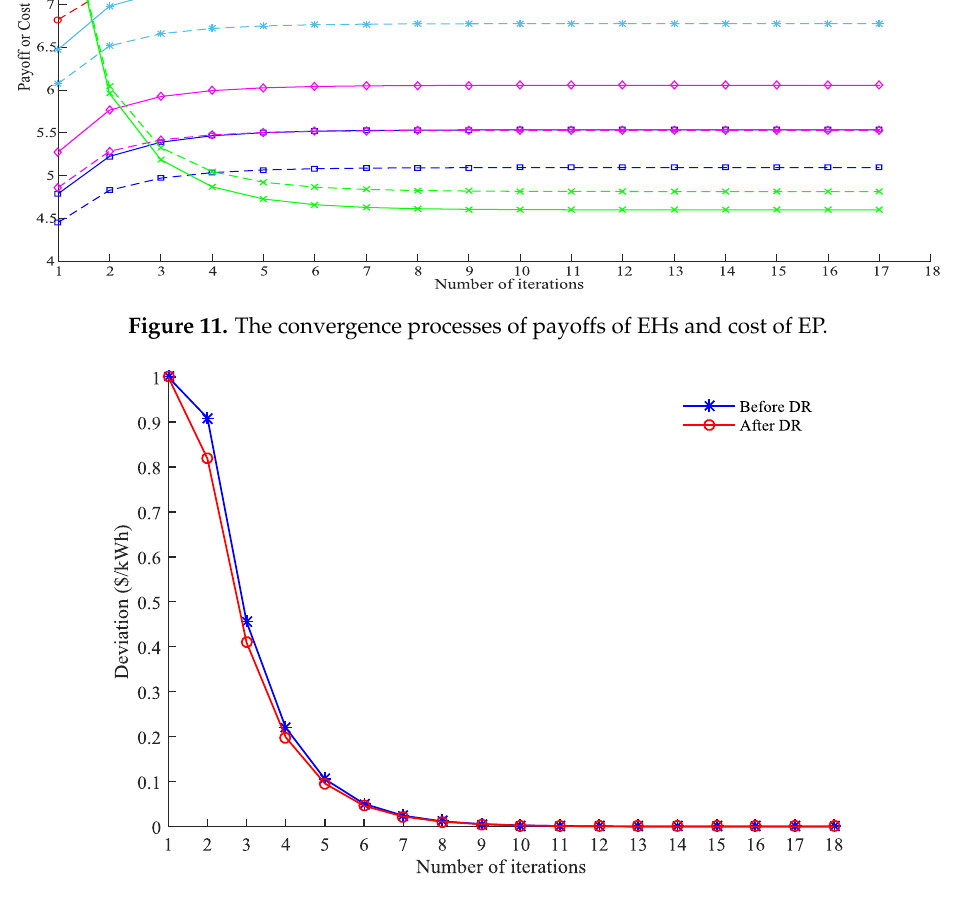
Figure 12. The changes of iteration deviation.